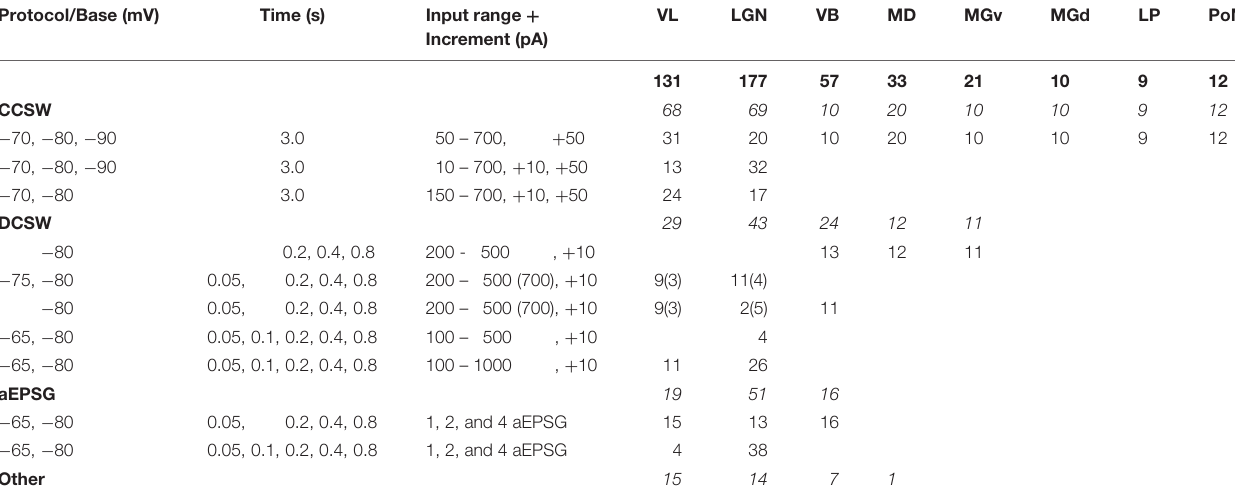
TABLE 2 | Protocols and numbers of recorded neurons. Protocol/Base